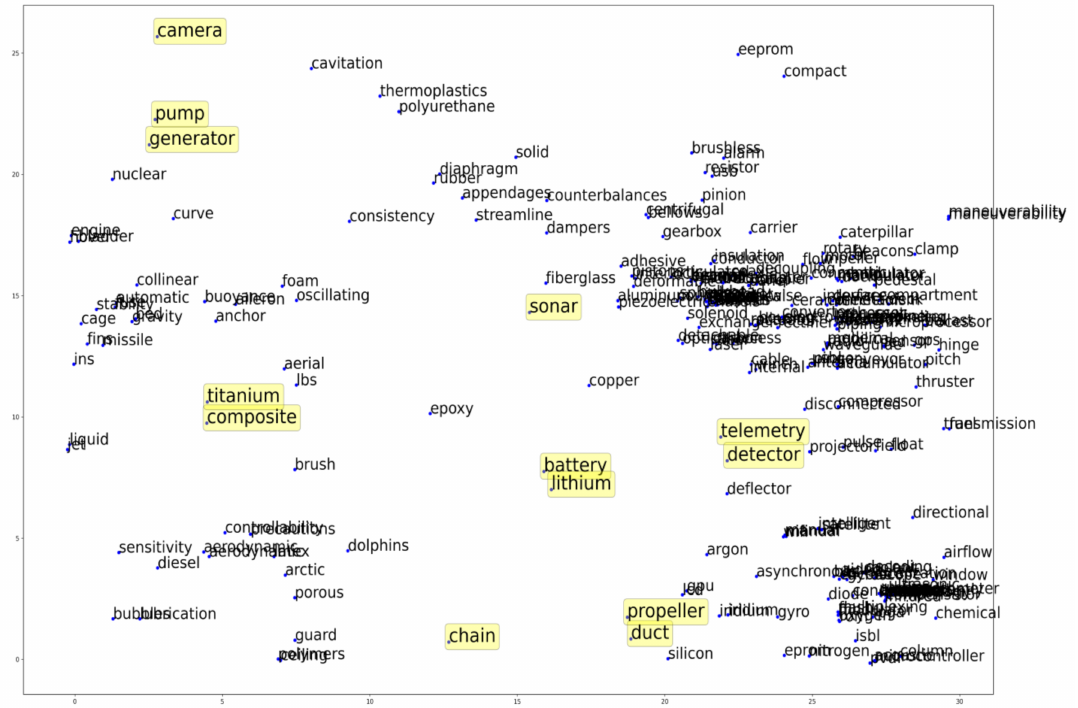
Figure 4. Sparse generative topographic mapping (SGTM)-based map for